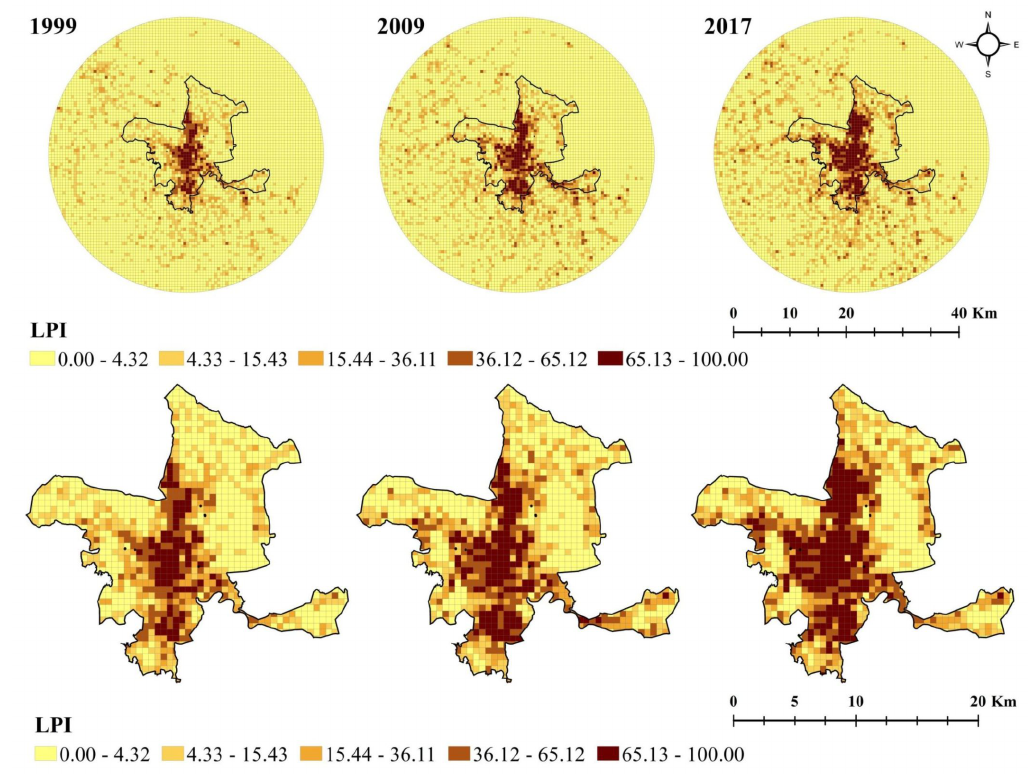
Figure 9. Largest patch index (LPI) change at 500 m cell-size with enlarged view of CA, year 1999, 2009 and 2017 in the study